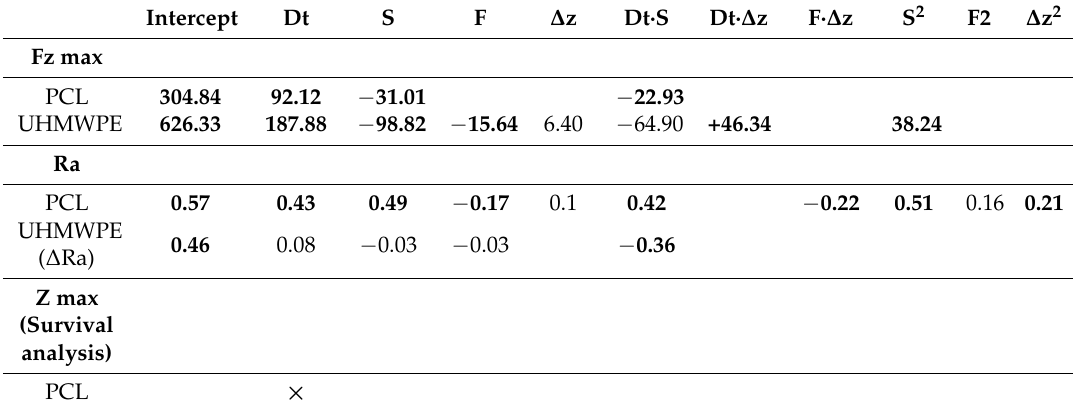
Table 5. Summary of the coefficients of the selected models (bold indicates significance ( α =